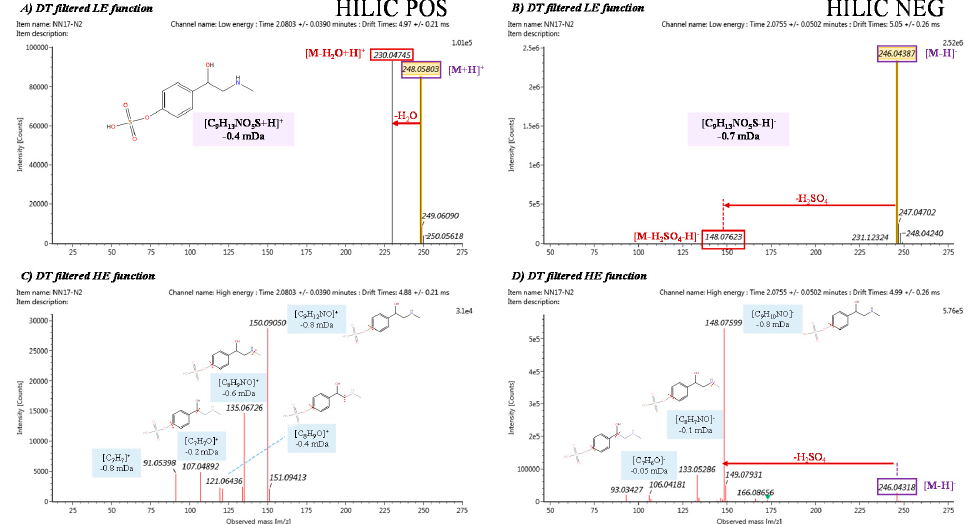
Figure 6. DT filtered HDMS E obtained for Marker 1: ( A ) LE function in HILIC pos analysis, ( B ) LE function in HILIC neg analysis, ( C ) HE function in HILIC pos analysis and ( D ) HE function in HILIC neg analysis. A proposed structure and fragmentation are